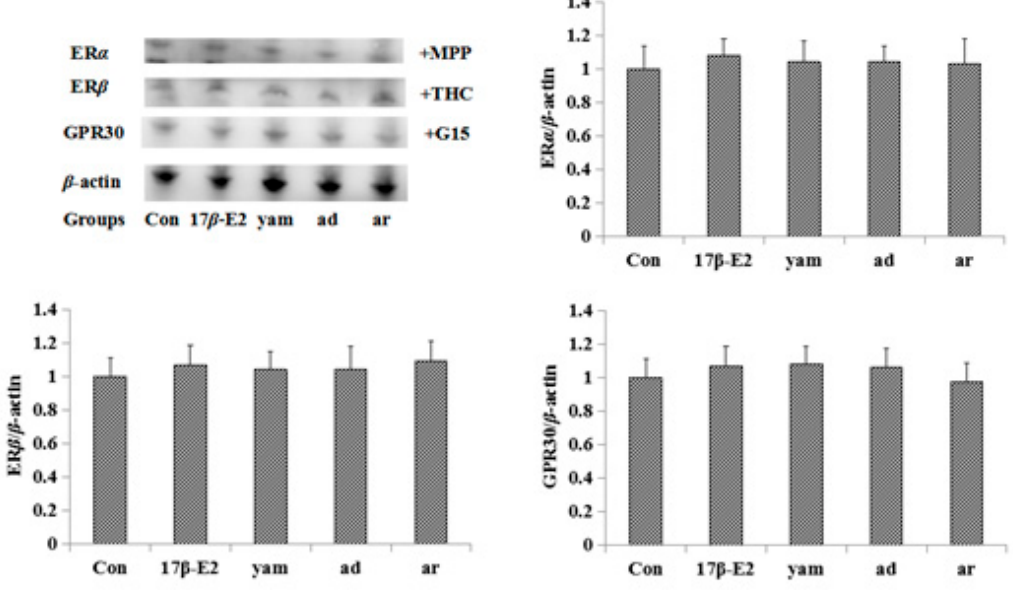
Figure 5. Effect of MPP, THC and G-15 on the expression of ER α , ER β and GPR30 in MCF-7 cells ( n = 3). The MPP, THC and GPR30 were added 30 minutes before treatment of 17 β -E2, yam, adenosine and arbutin.